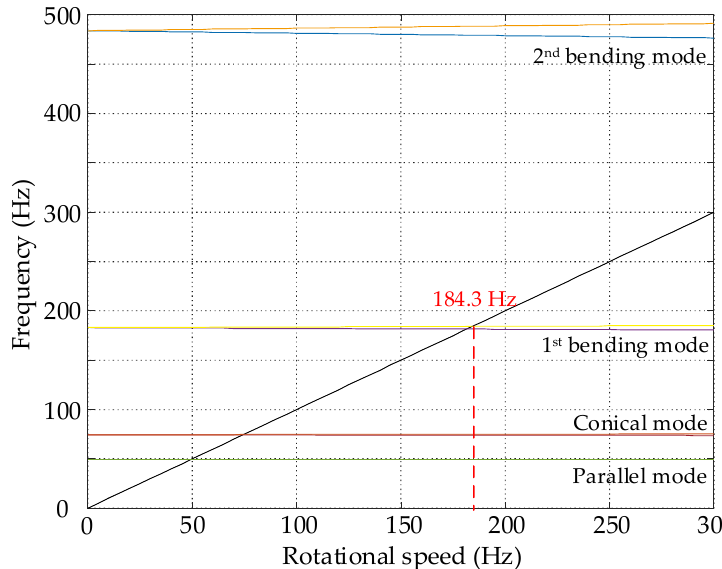
Figure 6. Campbell diagram of the flexible rotor.